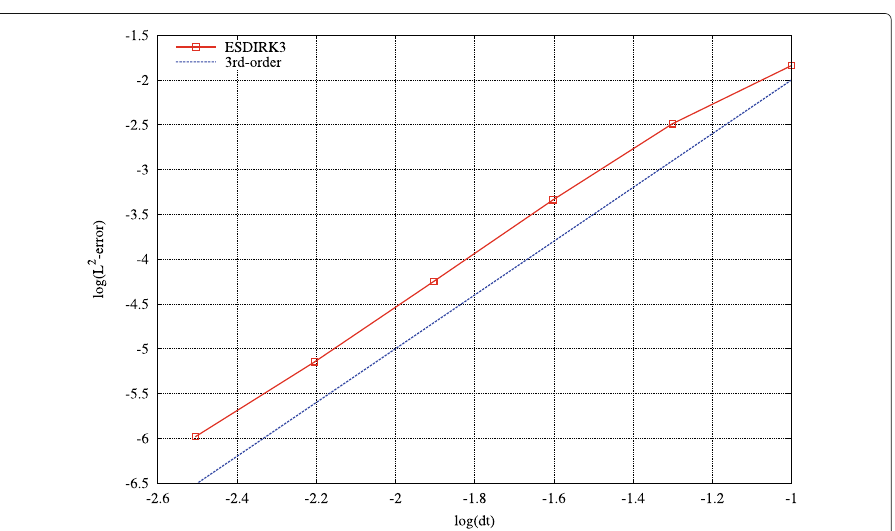
Fig. 7 Temporal convergence rate for ESDIRK3 scheme on the isentropic vortex